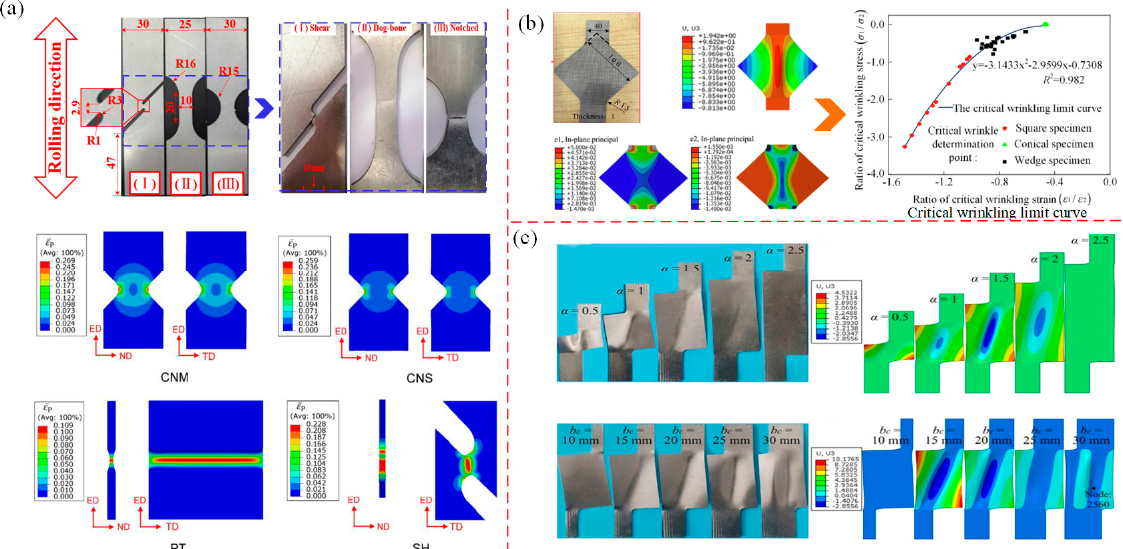
Figure 9. Deformation instability characteristics of sheet metal stretching: ( a ) local instability of a notched sheet metal specimen [117,118]; ( b ) wrinkling of the thin plate when stretched symmetri-